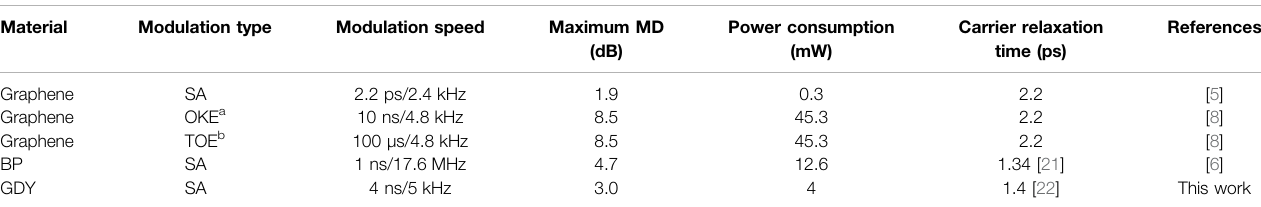
TABLE 1 | Comparison of typical 2D material-based nonlinear all-optical modulators.